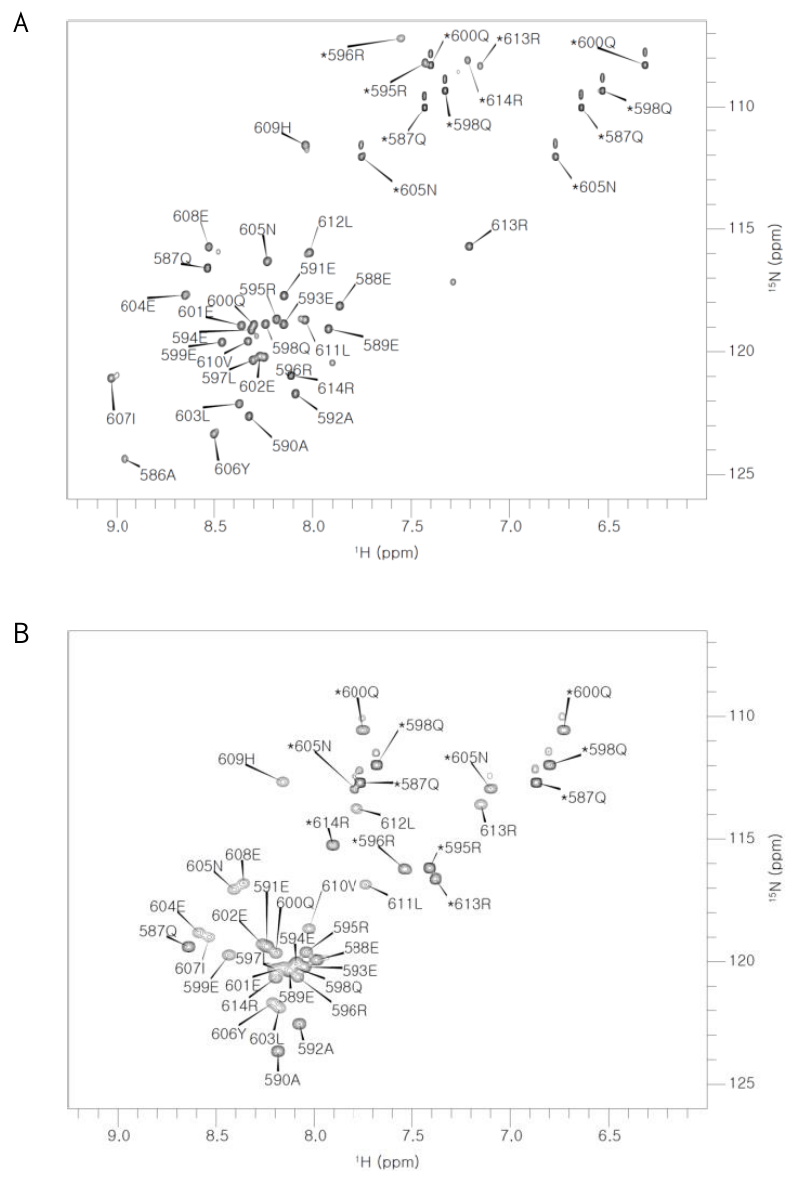
Figure 3. Assigned 1 H- 15 N-HSQC spectra of AQEE-30 ( A ) in the HFIP solution and ( B ) in the DPC micelle solution. The assigned peaks are labelled with single letter amino acid names and sequence numbers. Side-chain peaks are marked by asterisks. Table 1. AQEE-30 chemical shifts of the assigned 1H resonances in the HFIP solution.